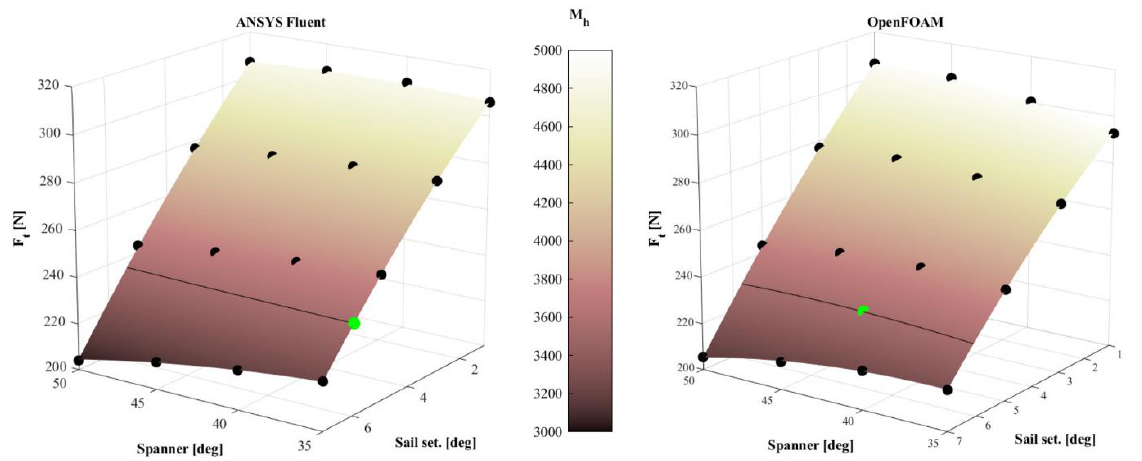
Figure 27. Comparison of the response surfaces obtained with the solutions of the two solvers. The colours of the response surfaces are associated to the value of the heeling